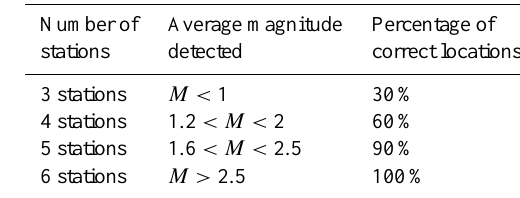
Table 1. Statistics of the correct location of the Alert